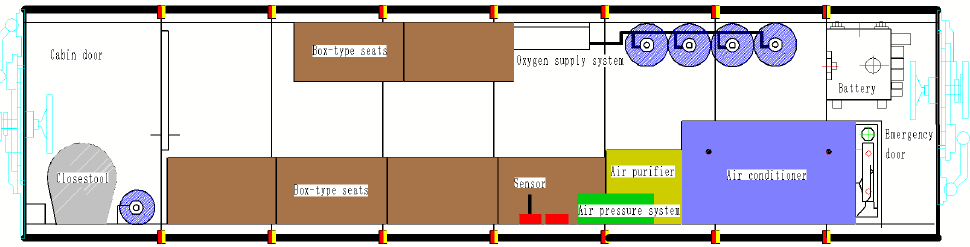
Figure 2. Internal structure of the coal mine emergency refuge system.